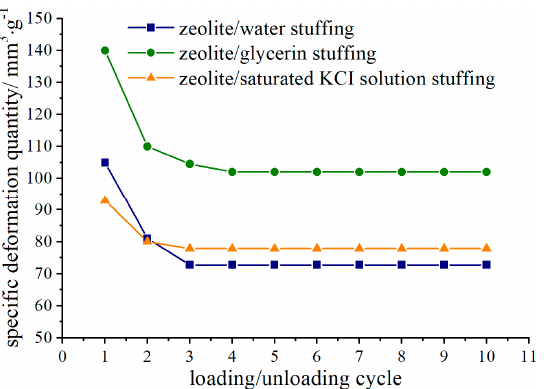
Figure 6. Specific deformation quantity of three kinds of zeolite-based stuffing under ten cyclic loadings (ZSM-5 zeolite/water stuffing, ZSM-5 zeolite/glycerin stuffing, and ZSM-5 zeolite/saturated KCl solution stuffing).